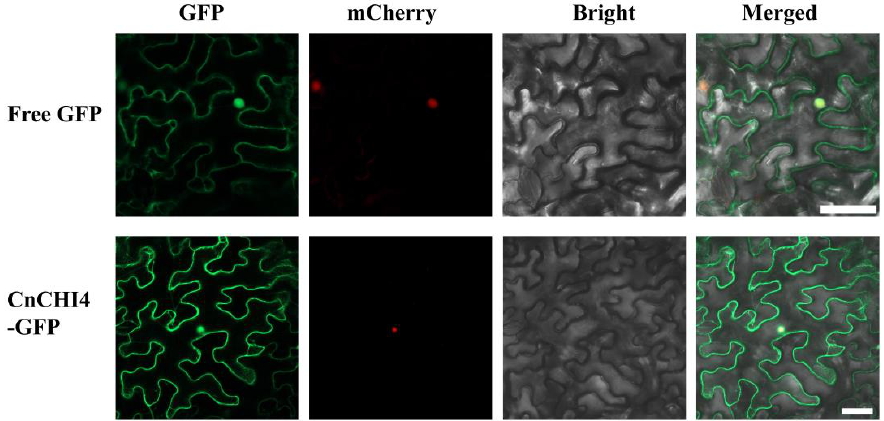
Figure 5. Subcellular localization of CnCHI4 in the leaves of N. benthamiana , co-expressed with nucleus-located mCherry. The empty vector was used as the control. GFP: images under green fluorescence channel; Bright: images under bright light; mCherry: images under red fluorescence channel; Merged: overlay plots. Bars = 50 µ m.